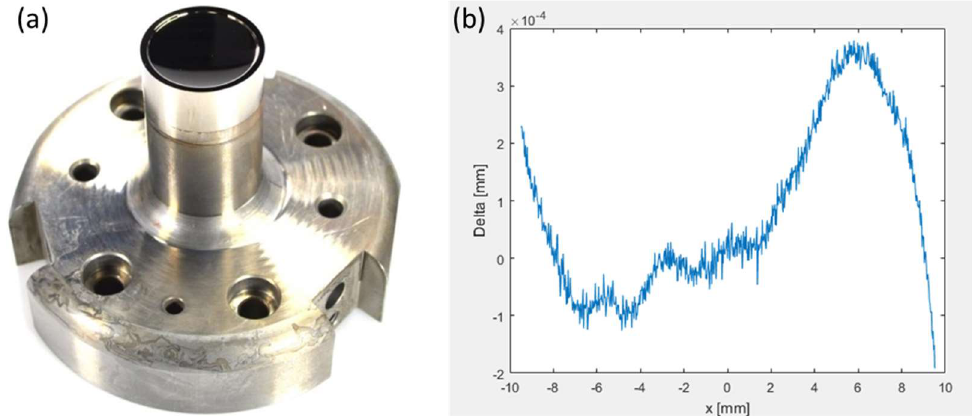
Figure 3. ( a ) Diamond turned mold insert, ( b ) form deviation of the optical aspheric surface with P-V < 1 µm (Peak to Valley).